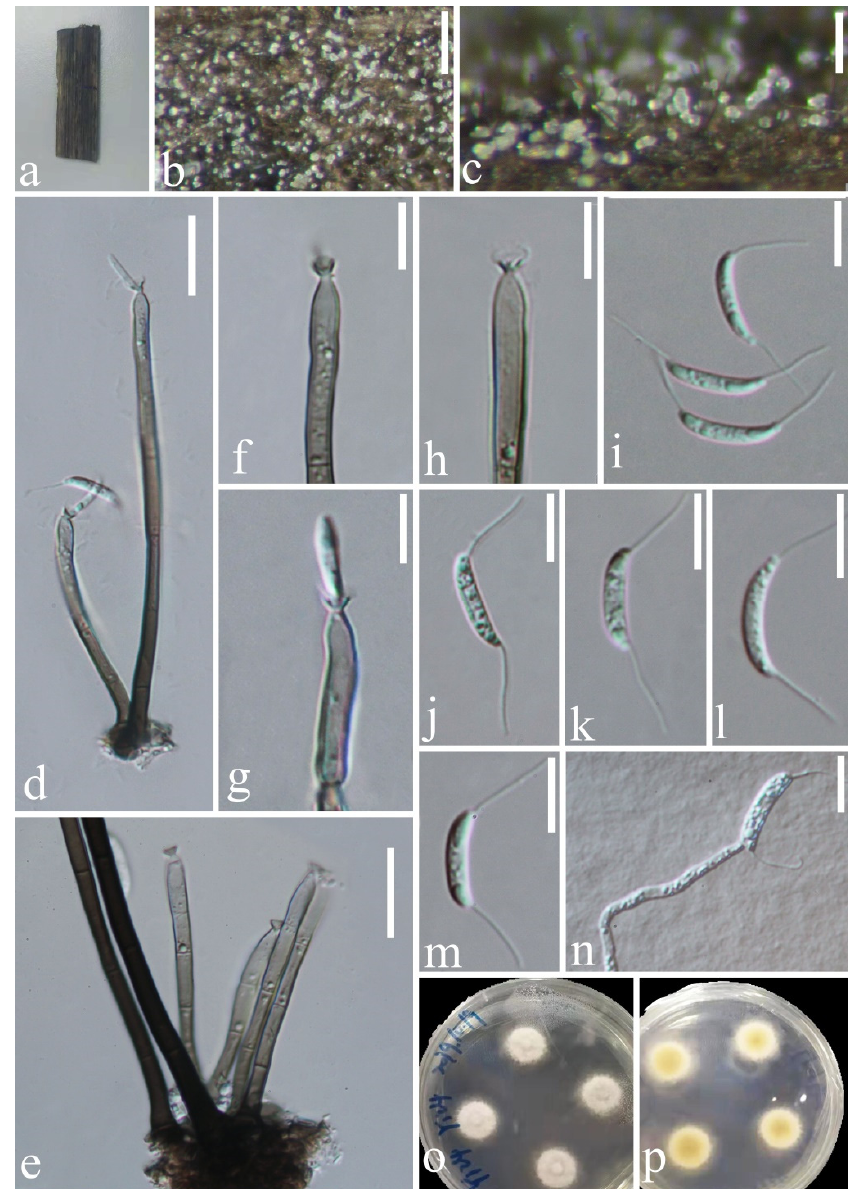
Figure 5. Codinaea terminalis (HKAS 123756). ( a ) Host material; ( b , c ) colonies on host surface; ( d , e ) conidiophores with conidiogenous cell; ( f – h ) conidiogenous cells; ( i – m ) conidia; ( n ) germinating condium; ( o , p ) culture on PDA from above and below. Scale bars: ( b ) 200 μ m; ( c ) 100 μ m; ( d , e ) 20 μ m; ( f – o ) 10 μ m.